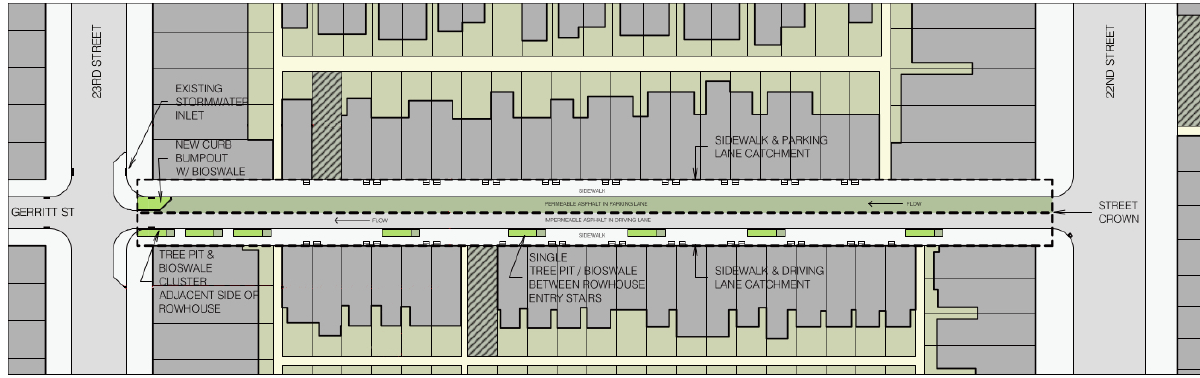
Figure 4. Model 1—Plan view of proposed streetscape GI.